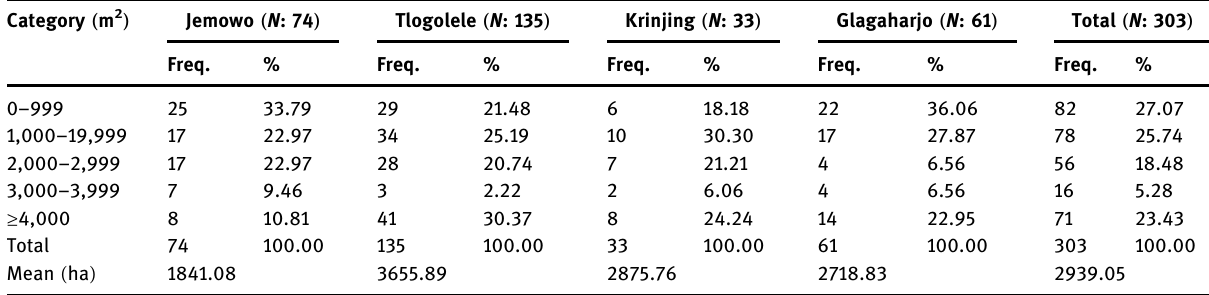
Table 7: Farm size of the respondents Category ( m 2 ) Jemowo ( N : 74 ) Tlogolele ( N : 135 ) Krinjing ( N : 33 ) Glagaharjo ( N : 61 ) Total ( N : 303 )